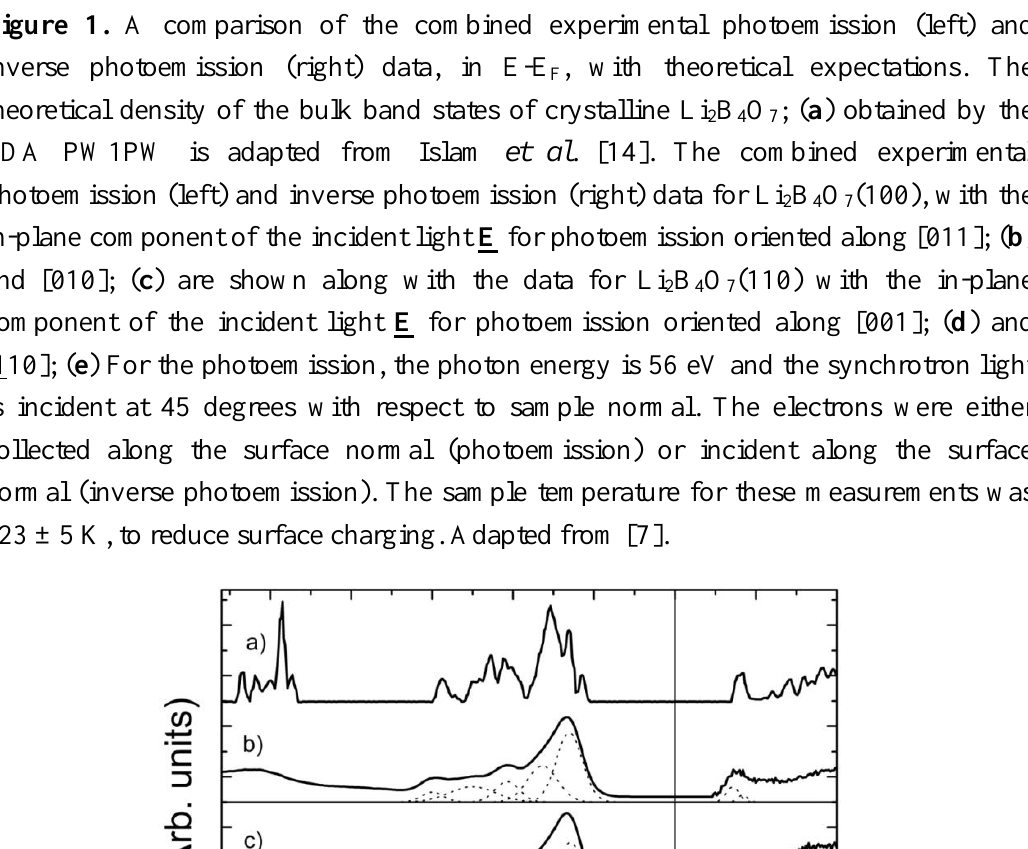
, with theoretical expectations. The F B O ; ( a ) obtained by the 2 4 7 B O (100), with the 2 4 7 B O (110) with the in-plane 2 4 7